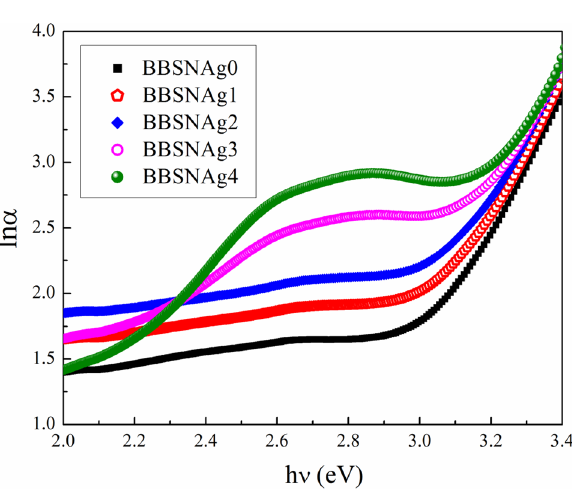
Figure 7. Dependence of ln (α) on the photon energy ( h υ ) for prepared